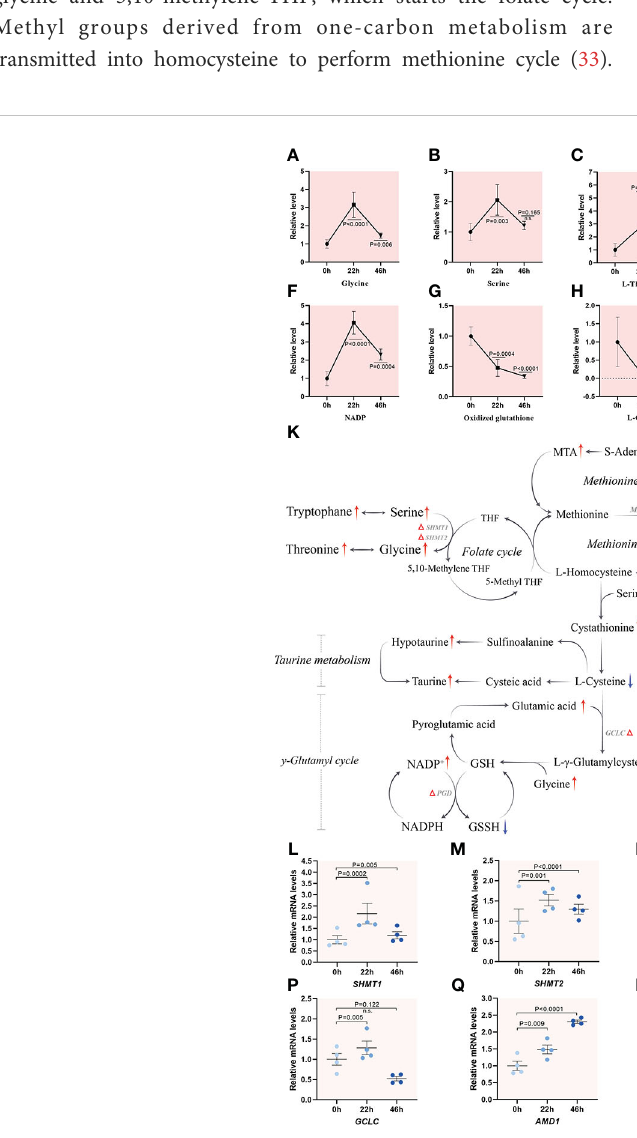
FIGURE 5 Active one-carbon metabolism in porcine oocytes. (A – J) Relative levels of metabolites related to one-carbon metabolism in oocytes at three time points. (K) Overview of the metabolic processes of one-carbon metabolism in porcine oocytes upon meiotic resumption, derived from metabolomics and transcriptomics. The red and blue arrows denote the metabolites that are upregulated and downregulated, respectively. Differential expression genes increased and decreased are indicated by red and blue triangles, respectively. (L – S) Relative levels of representative genes involved in inputs and outputs of one-carbon metabolism during meiotic resumption. Error bars, SD. Student ’ s t test was used for statistical analysis in all panels, comparing to GV. n.s., not signi fi